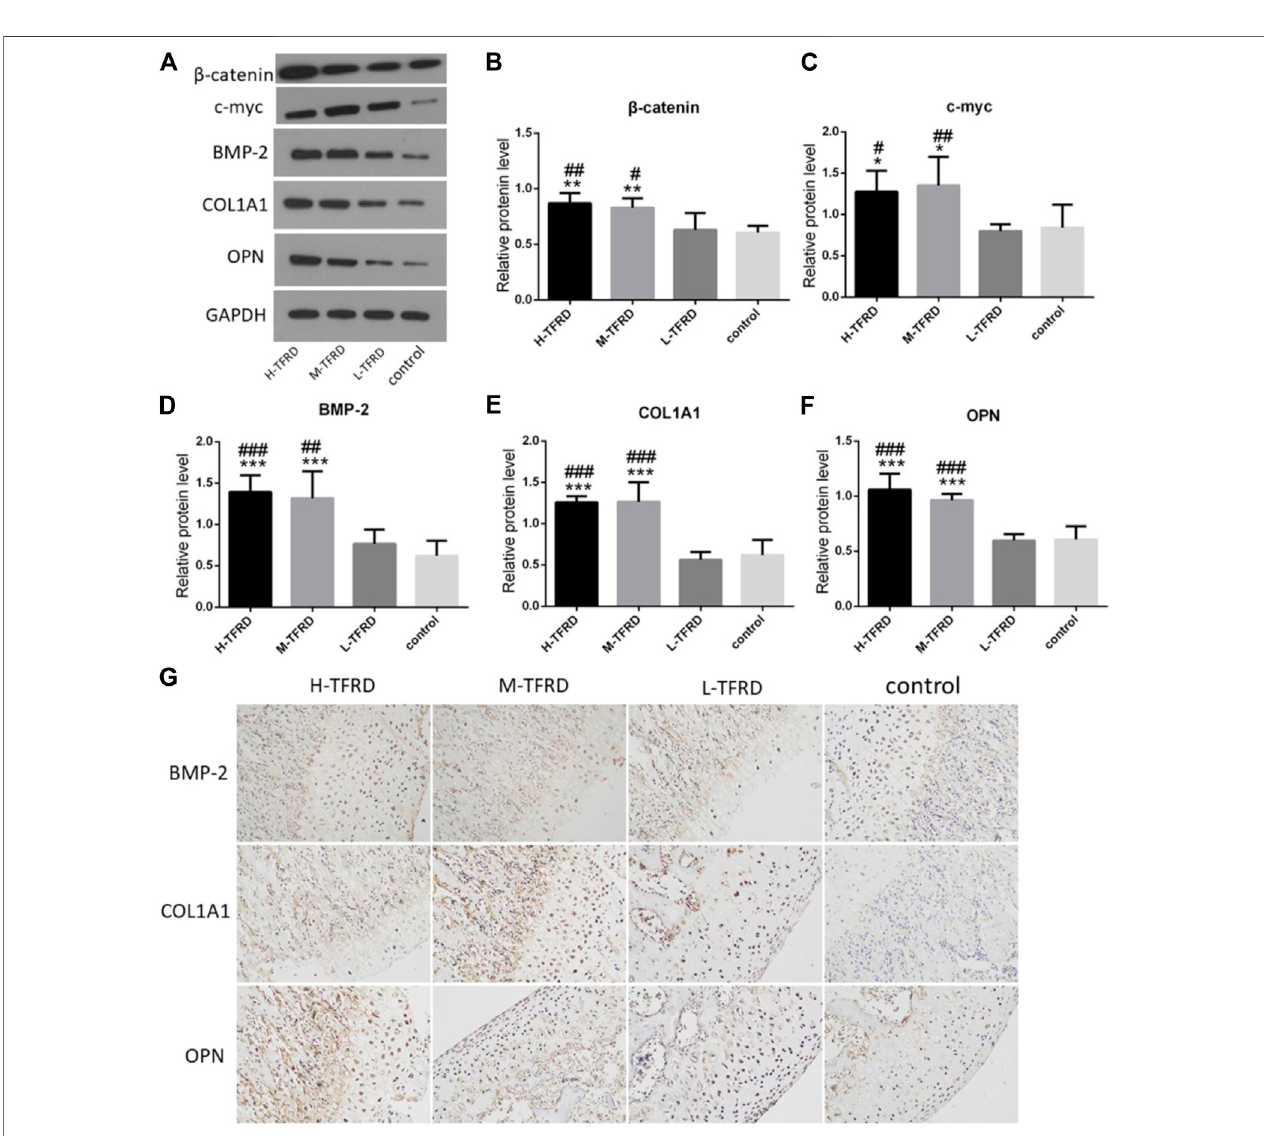
FIGURE 2 | TFRD promotes expression of Wnt/ β -catenin and osteogenesis-related proteins in the bone graft. (A) is the Western Blot band of β -catenin, c-myc, BMP-2, COL1A1 and OPN respectively. (B – F) is the gray value of β -catenin, c-myc, BMP-2, COL1A1 and OPN. Each value was presented as the mean ± SD. *** p < 0.001, ** p < 0.01, * p < 0.05 vs. the control group; ### p < 0.001, ## p < 0.01, # p < 0.05 vs. the L-TFRD group. (G) Immunohistostaining was performed to evaluate the proteinlevelofBMP-2,COL1A1andOPNinbonegraftarea(magni fi cation, × 200).Theintensityandareaofthreeosteogenesis-relatedproteinsintheH-TFRDand M-TFRD groups were higher than those in the L-TFRD and control groups.